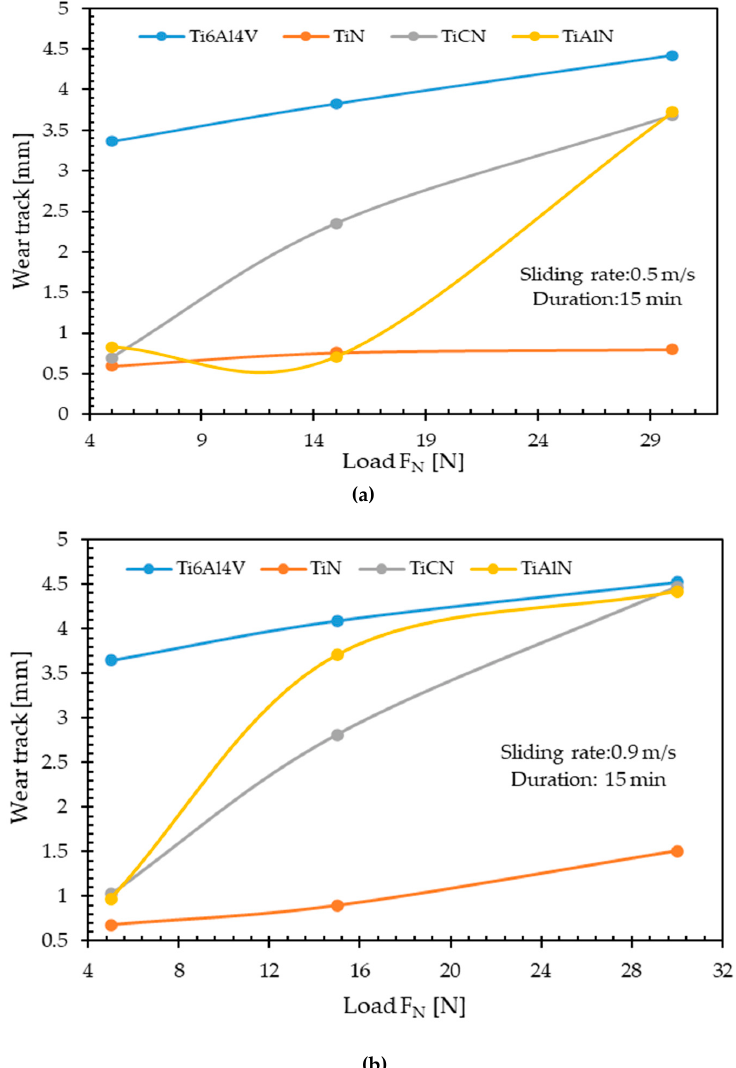
Figure 14. The variation in wear track with a load. ( a ) 0.5 m/s sliding rate, ( b ) 0.9 m/s sliding rate. The wear track width values increased with the increase in load. With the increase in the sliding rate, the wear track width values showed a more considerable increase. Alt- hough it is determined that there is a significant difference between uncoated and coated samples at low loads, this difference decreases as the load increases. The lowest wear rate was achieved in the TiN coating. XRD analyses revealed that fine-grained structures were obtained by coating. The strength of fine-grained structures is higher than coarse-grained ones. TiN showed a small grain size of 6.4 microns in the (111) orientation, so it became the coating with the highest wear resistance. The low wear